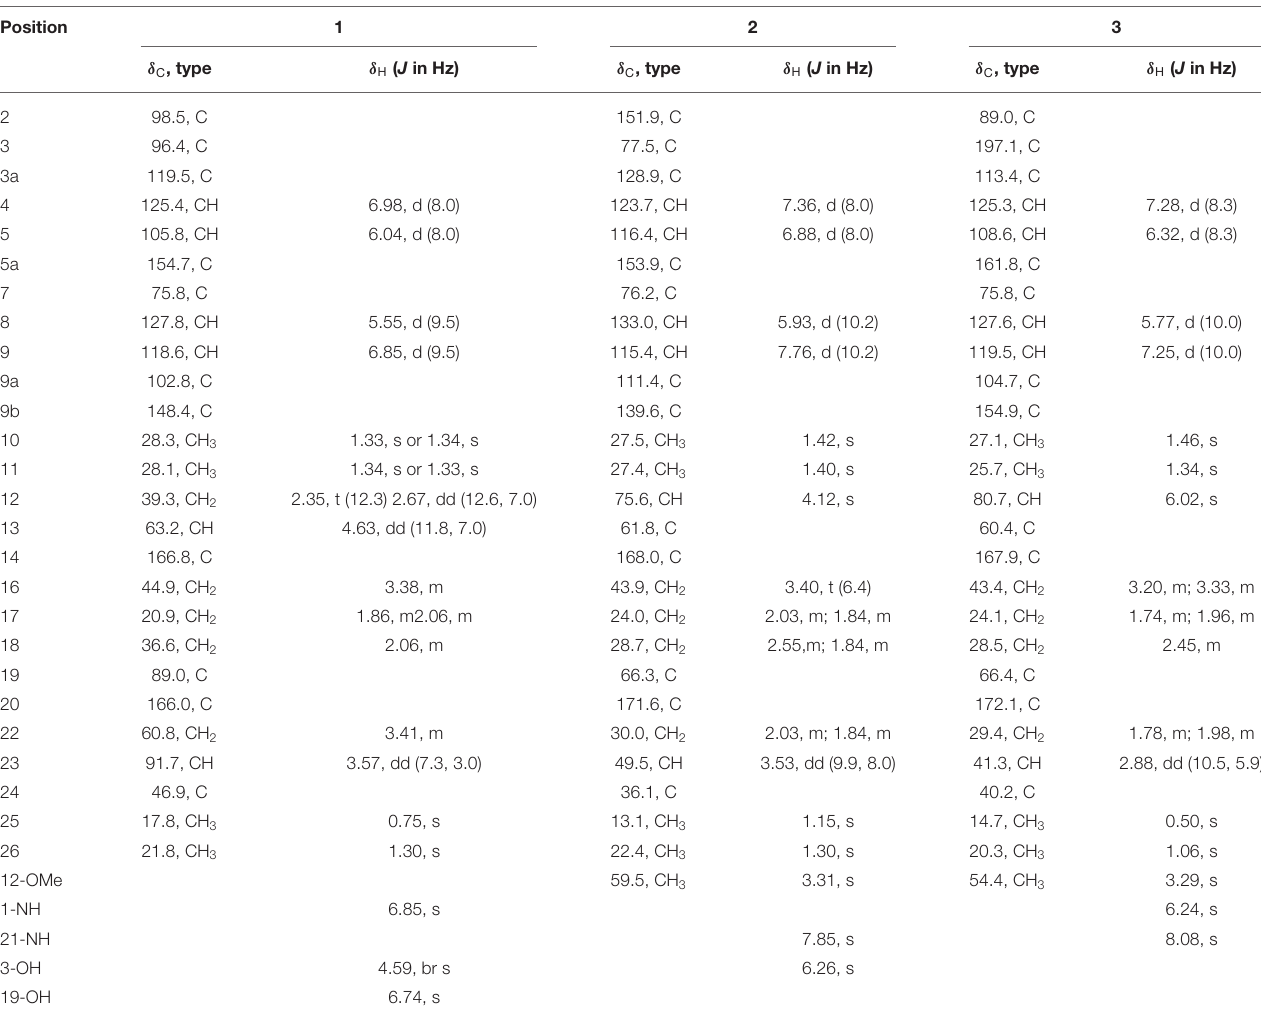
TABLE 1 | 1 H (500 MHz) NMR data and 13 C (125 MHz) NMR data for 1 – 3 in DMSO- d 6 . Position